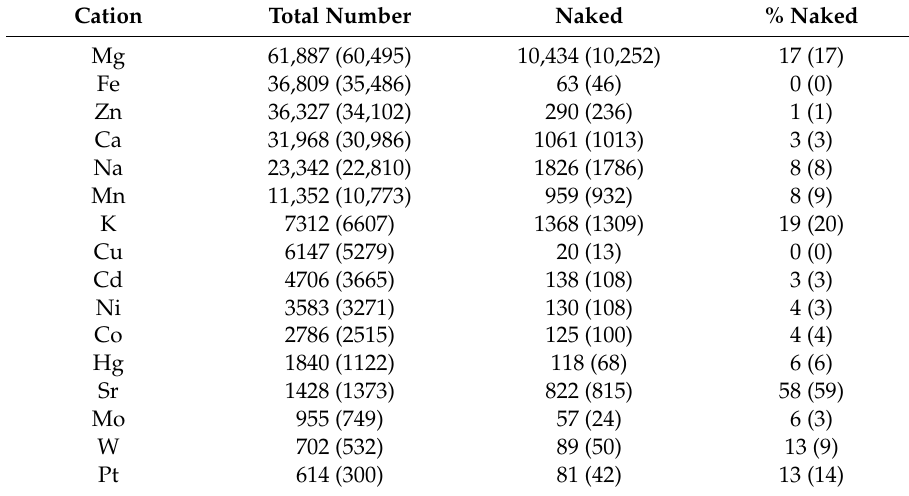
Table 1. The metal cations more frequently (at least 500 times) found in the Protein Data Bank. The following quantities were reported for each cation: The total number of occurrences in the Protein Data Bank (Total number), the occurrences in which the cation is naked (Naked), and the percentage of naked cations (% naked). The numbers in parentheses are the number occurrences, computed as the sum of the occupancy values deposited in the Protein Data Bank. Cation Total Number Naked % Naked Mg 61,887 (60,495) 10,434